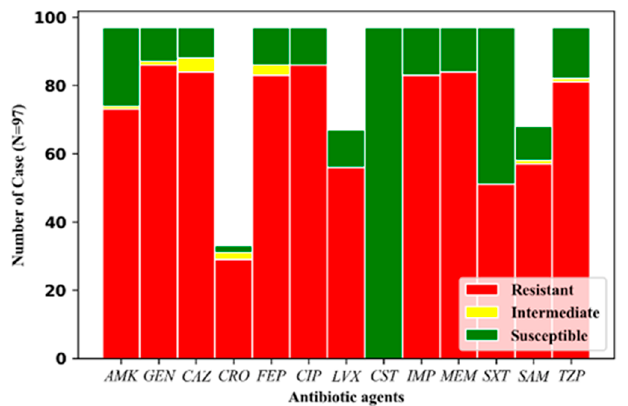
Figure 3. Antibiotic resistance profile of the 97 Ab strains in this study.